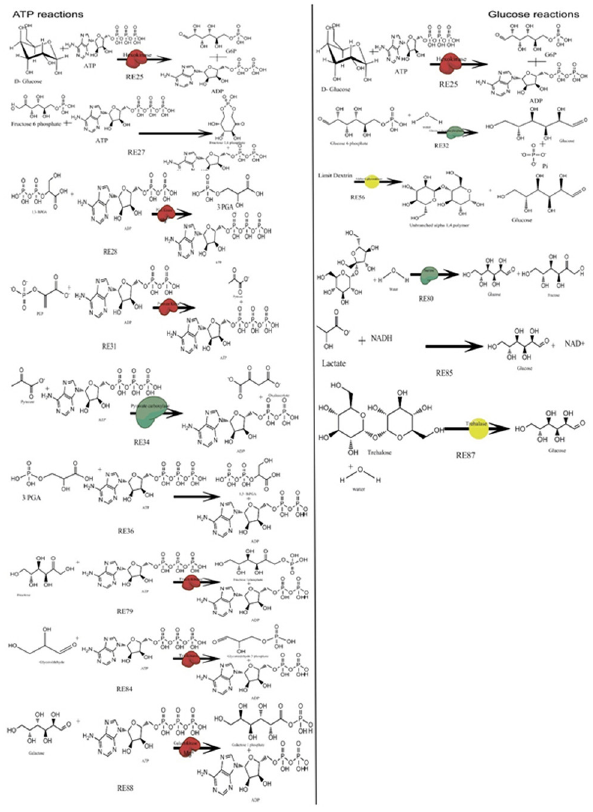
Fig 1. Reactions involving ATP and Glucose used in HEPNet. RE refers to Reaction id. A single ATP molecule is connected to 10 odd reactions and 7 reactions in case of glucose, in the human metabolome. All these reactions are responsible for playing a key role in the Flux Balance Analysis. The cumulative flux of these reactions determines the behavior of HEPNet working in view of Glycaemic condition. As we talk of the energy pool, ATP plays the central role and hence it is reduced in reactions RE25, RE27, RE34, RE36, RE79, RE84, RE88 where reducing agents are Glucose, Fructose 6 phosphate, Pyruvate, 3PGA, Fructose, Glyceraldehyde and Galactose respectively. Also, it has been found that ATP is being produced upon oxidation, where 1,3 BiPGA and PEP acts as oxidizing agents in reactions RE28 and RE31. Glucose is produced in many of the reactions due to the reduction of the product being carried out enzymatically or by the presence of another energy currency